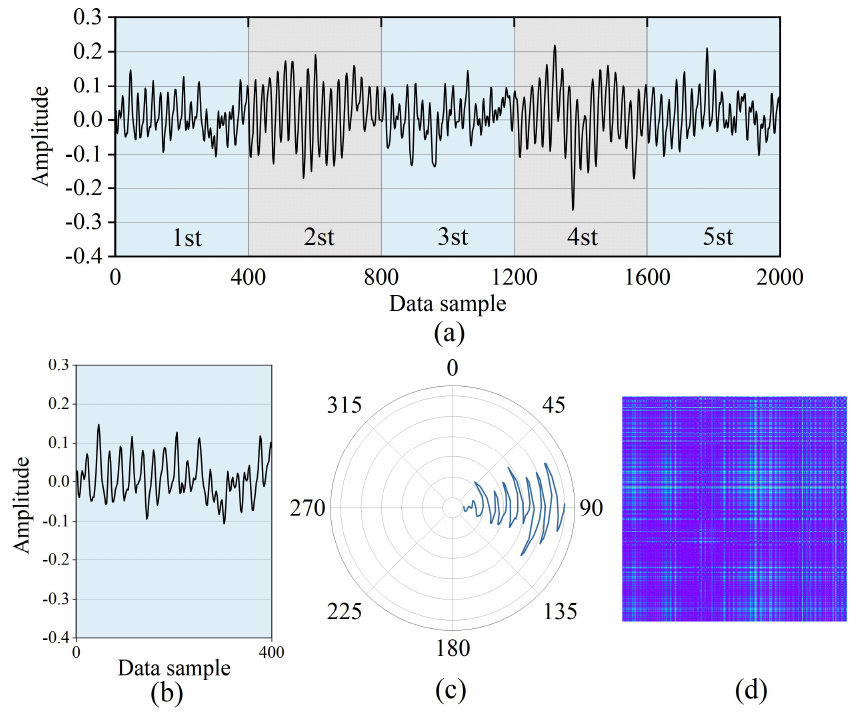
Figure 1. ( a ) Original time-domain vibration signal, ( b ) Subsequence 1, ( c ) Convert to pole coordinate after normalization, ( d ) Generate a GAF image.